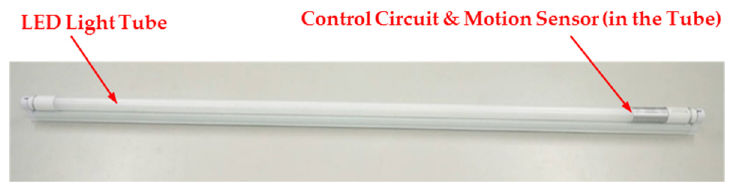
Figure 2. A new type of LED sensor light lamp (T8 LED light tube) [1].